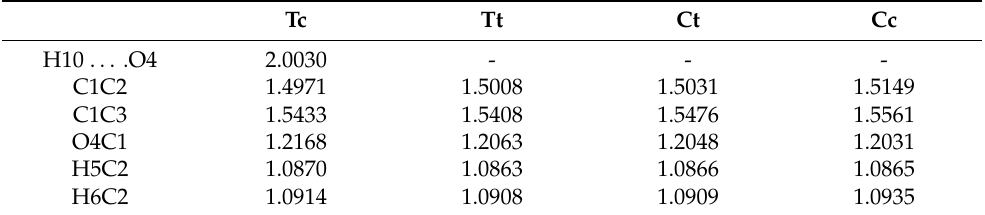
Figure 2. The four pyruvic acid conformers. The relative energies are given in Table 1. Table 2. CCSD(T)-F12/AVTZ-F12 equilibrium structural parameters (distances, in Å, angles, in The Tc form stabilizes by the formation of an intramolecular hydrogen bond degrees) of pyruvic acid (H10….O4 = 2.0030 Å ). The next two conformers Tt and Ct lie in the 950–2000 cm −1 region. In previous papers [18], the higher energy conformer Cc is ignored since it is very unlikely to be observed. Although, it is described as a transition state by several levels of theory, all the MP2/AVTZ harmonic wavenumbers are real. The low stability of Cc is due to the non-bonding repulsions between H10 and its neighboring methyl group hydrogens.